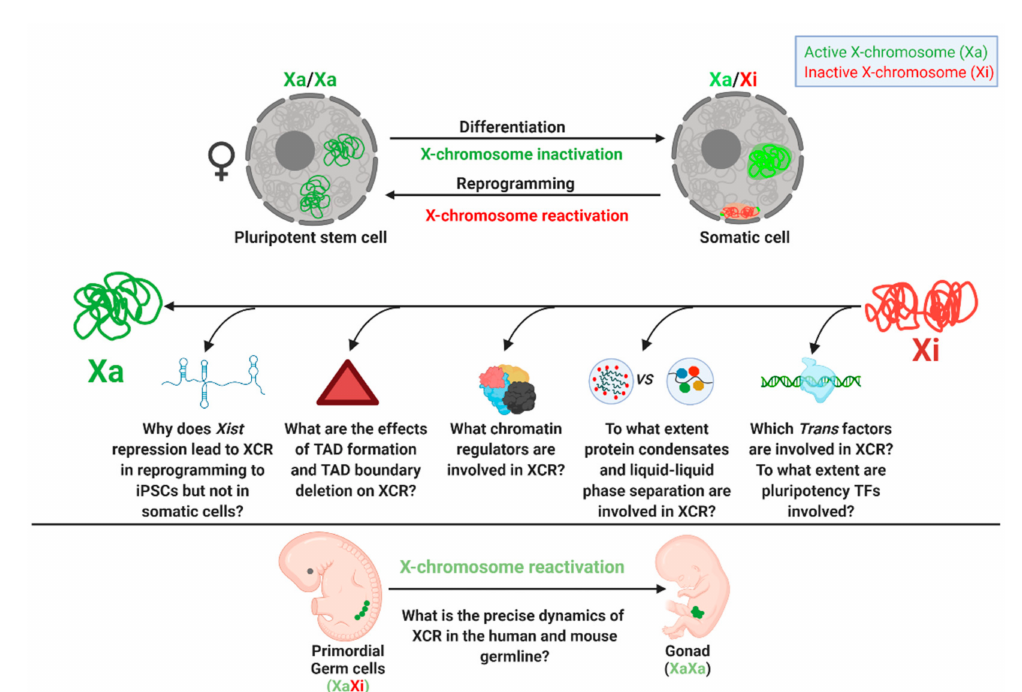
Figure 4. Gaps in our knowledge of XCR. Several unanswered questions during X-chromosome reactivations during reprogramming to pluripotent stem cell from somatic cell and also during germline development are